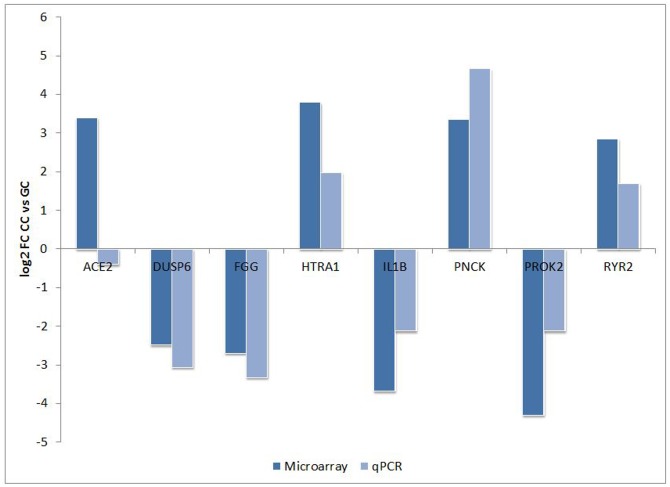
Validation of microarray results by qPCR in additional 19 GC and 19 CC samples, derived from sixteen women.For all genes, except ACE2, there was a statistically significant difference in expression between CC and GC. Data are presented as mean log2 fold change (FC) between expression in CC and GC. Blue bars represent log2 FC as measured by microarray; red bars represent log2 FC as measured by qPCR.